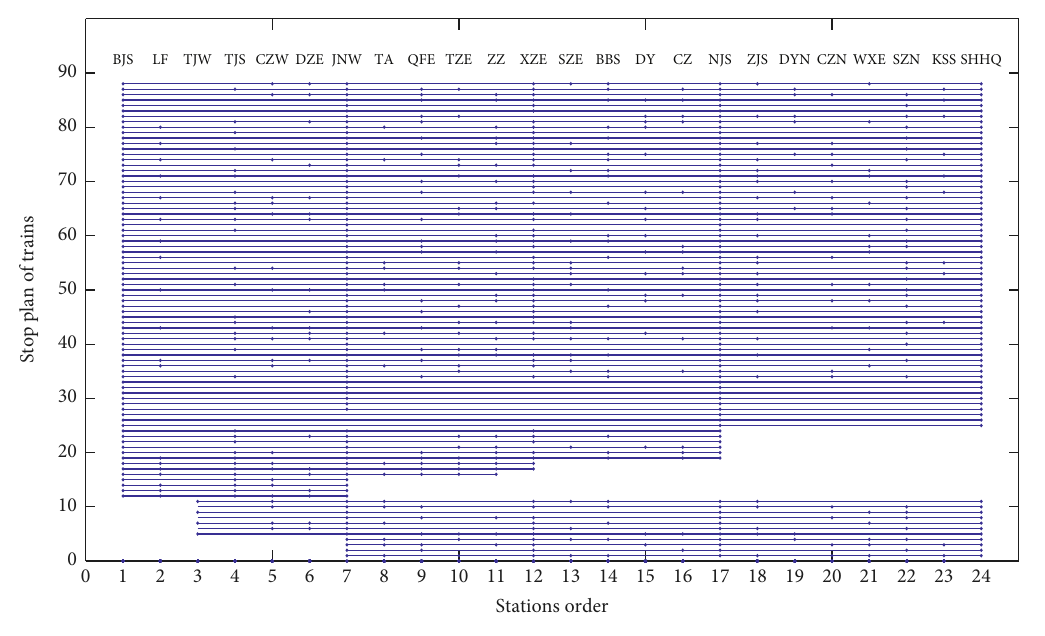
Figure 7: Optimal stop plan results.